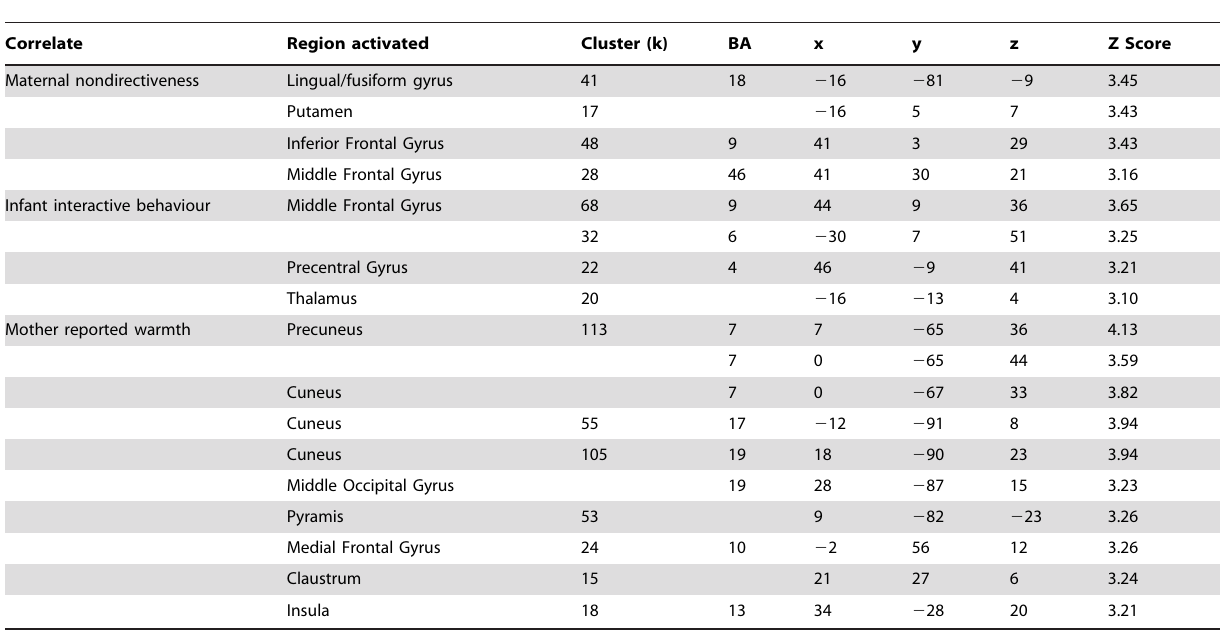
Table 5. Behavioural and mother-reported correlates with own . unknown infant contrast.*